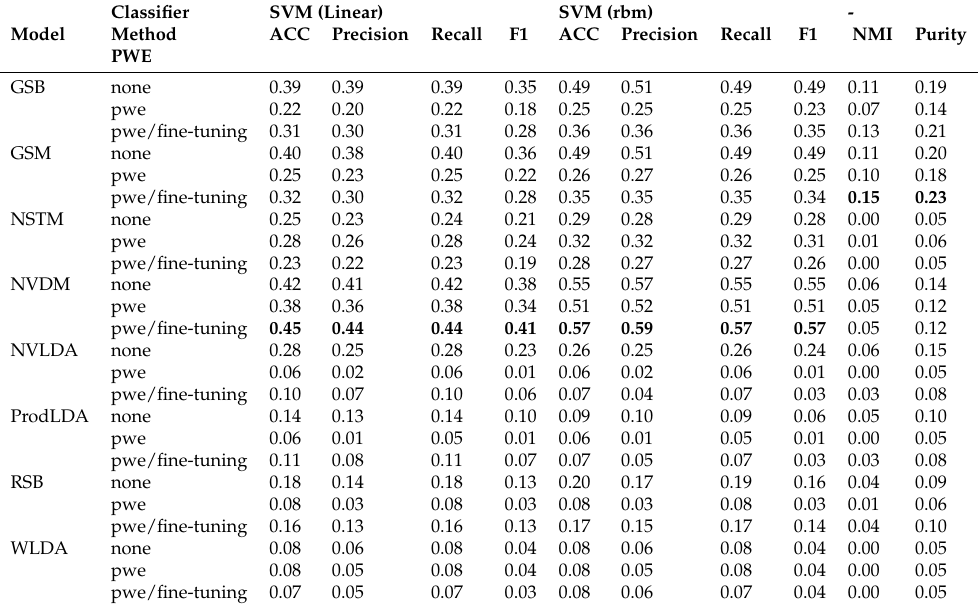
Table 25. Classification and Clustering performance on